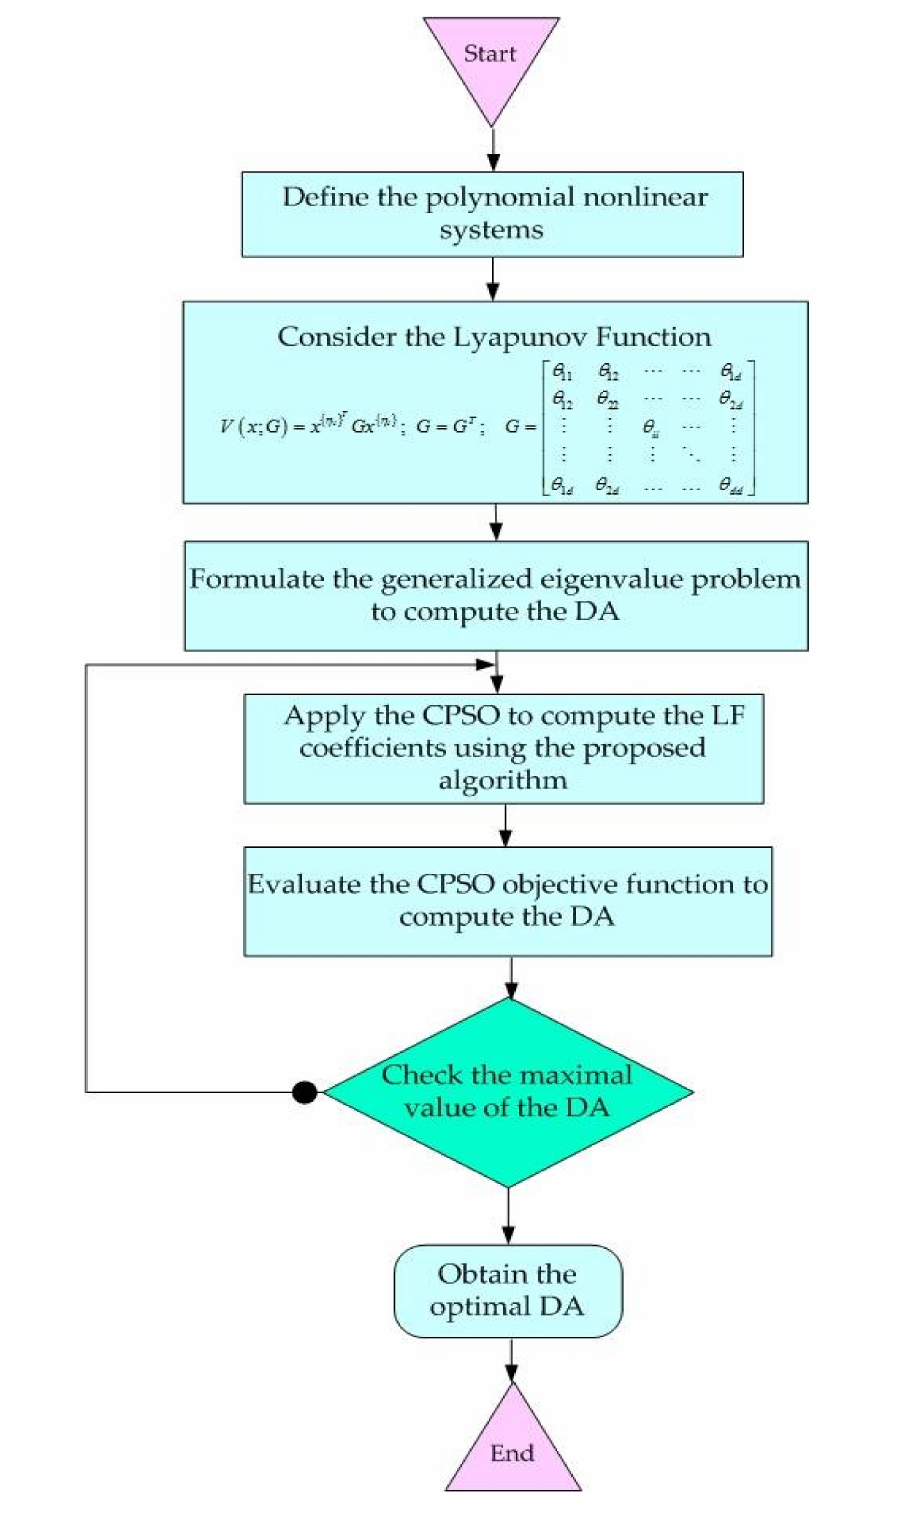
Figure 2. Flowchart of the CPSO method for estimating the attraction